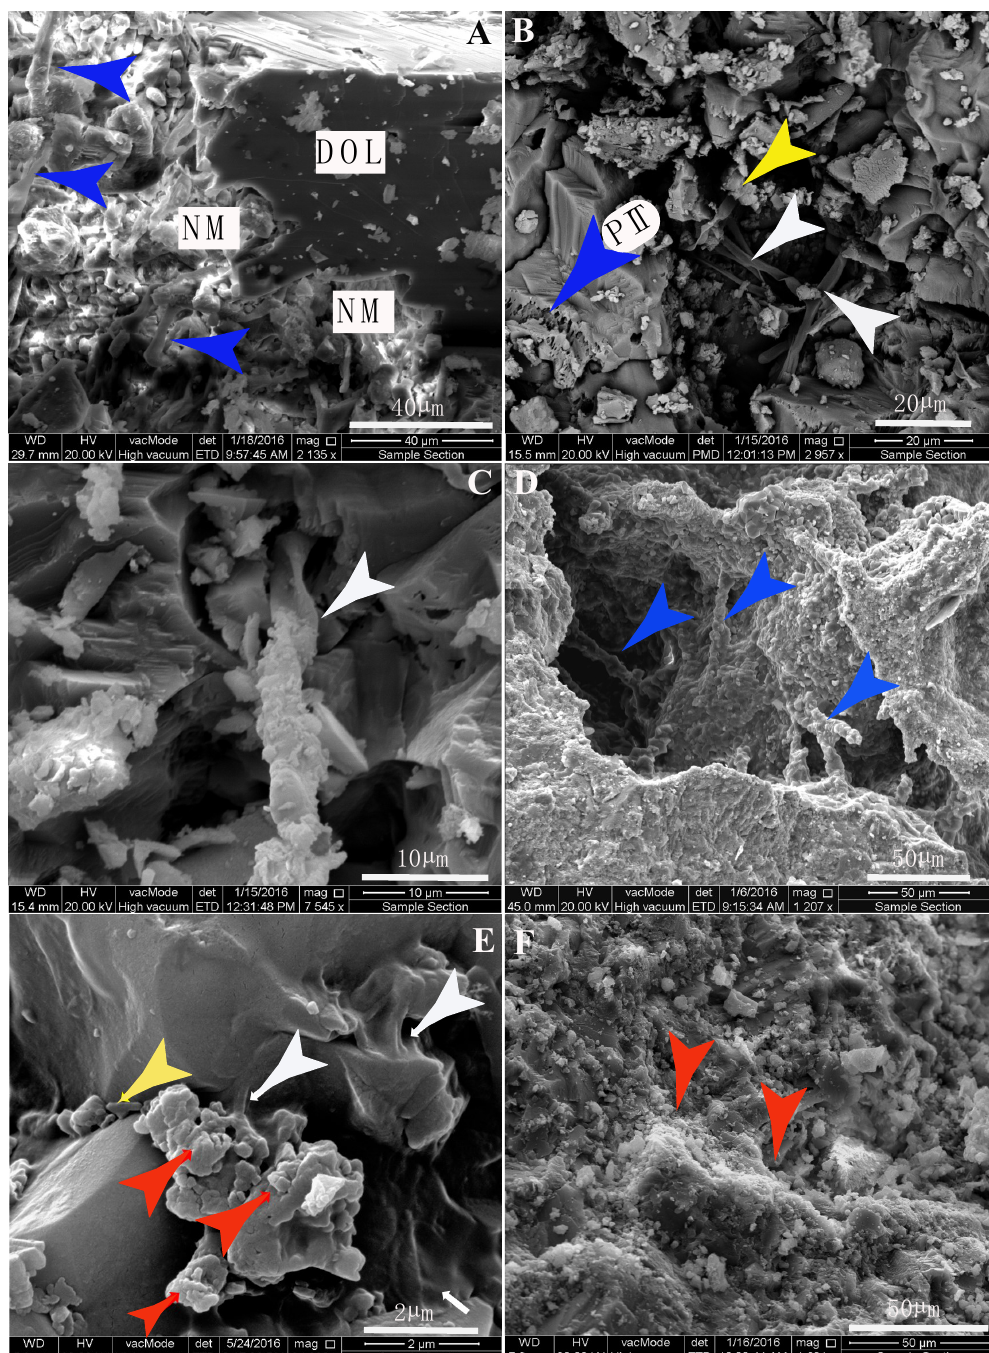
Figure 12. ( A – F ) SEM micrographs illustrating microbial diagenetic process on preexisting mineral surfaces. Spelek section. ( A ) Dissolution of original substrate and microbially (arrows) precipitated neominerals (NM). The microbial attack caused the strong dissolution of the dolomite crystal (DOL). Microbial filaments (arrows) are visible within the altered substrate. ( B ) The central part of the micrograph shows calcified dichotomous filament (white arrows), probably of fungal origin. Pitted dissolution (PIT) is also observed associated with deposition of neominerals (yellow arrow) indicating the microbially alteration of Bekhme Fm. ( C ) Fungal hyphae (arrow) perforating the original substrate, showing extensive encrustation with biomineral, indicating the important role of microorganisms in the calcretization process (see text). ( D ) Dissolution of the original substrate by root and rootlets of plants, resulting in the development of the alveolar texture. Wall bridging of such pores is related to